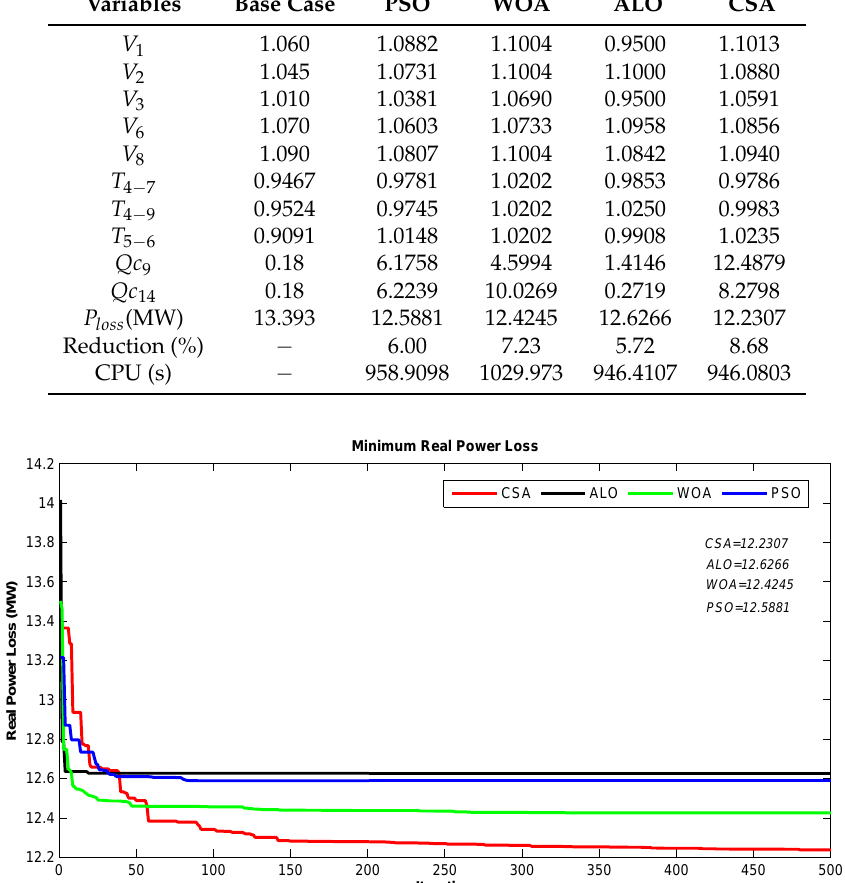
Figure 3. Performance loss convergence characteristics for IEEE 14-bus test using PSO (blue), WOA (green), ALO (black) and